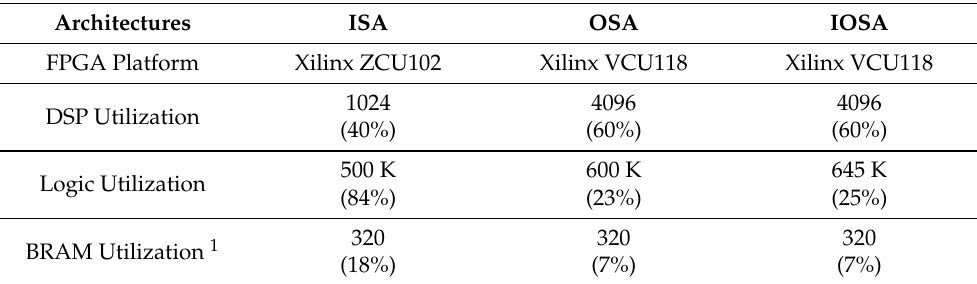
Table 4. Resource Utilization Details for Proposed